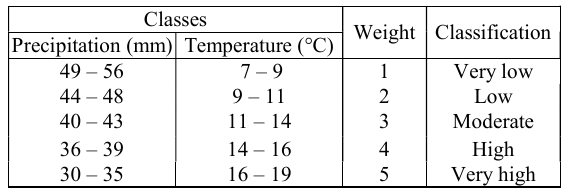
Table 2. Weighting for climate